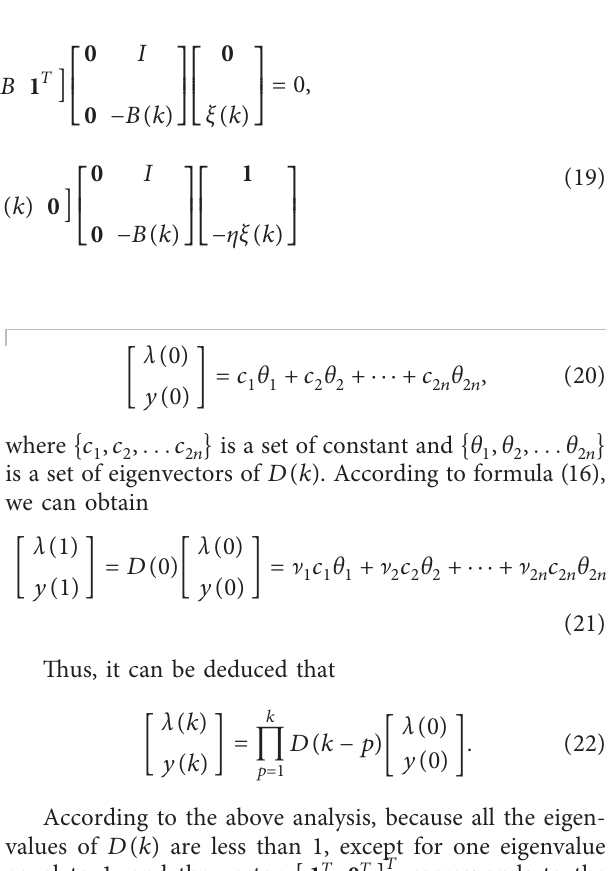
Figure 1: Two scenarios caused by DoS attacks. (a) Communication network topologies are still strongly connected. (b) Communication network topologies are